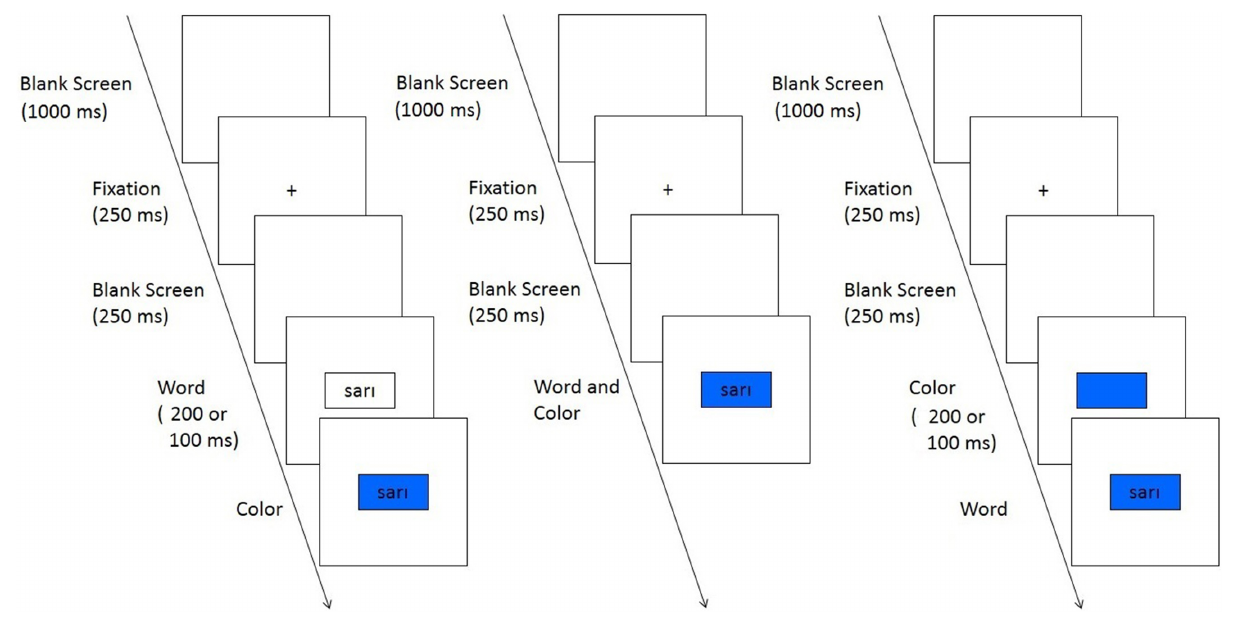
FIGURE 1 | Trial sequence of Experiments 1 and 2. Participants named the color of the rectangle. The word appeared before (left), at the same time (middle) or after the colored rectangle (right). The figure is not drawn in scale. Durations are presented in parentheses.